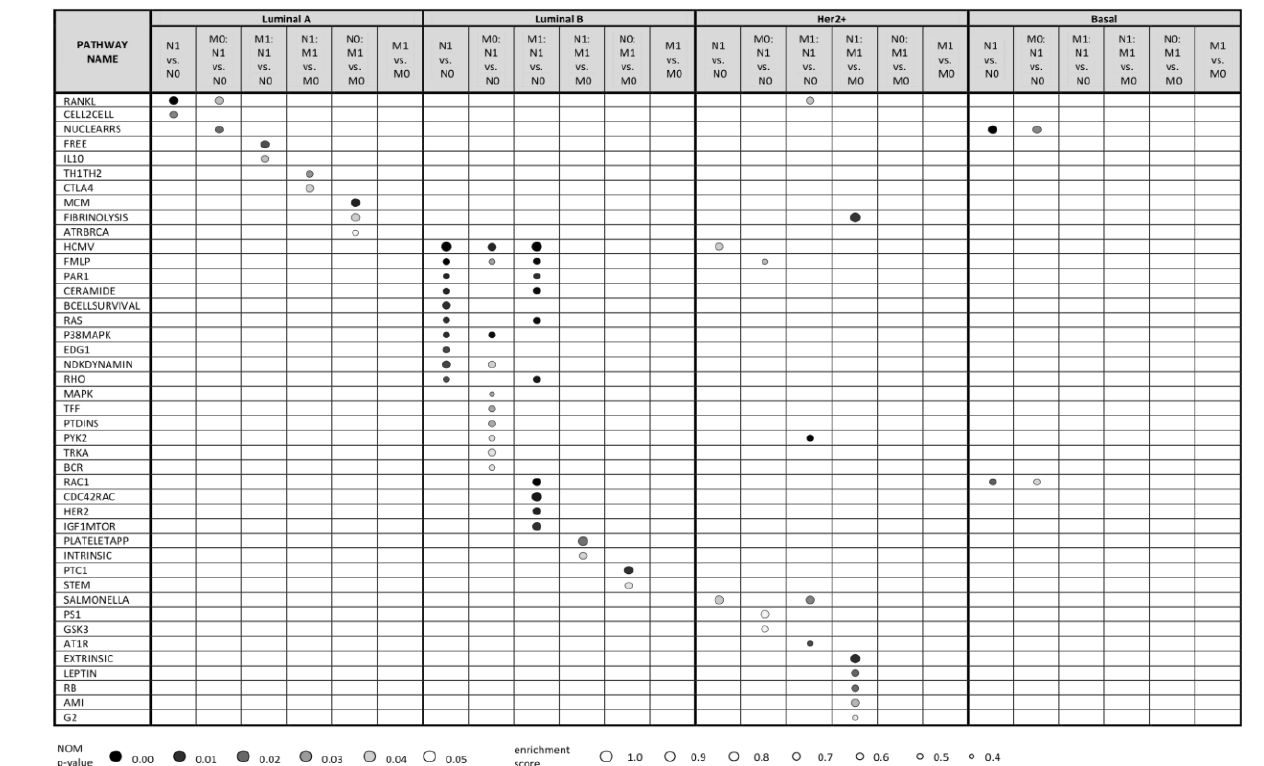
Figure 1. Top 10 statistically significant pathways (NOM p -value < 0.05) resulting from Gene Set Enrichment Analysis (GSEA) based on transcriptomic profiles of breast cancer patients from SUPERTAM_HGU133A dataset. Using SCMOD2 classifier, patients were classified into 4 breast cancer molecular subtypes, resulting in 341 luminal A, 281 luminal B, 71 Her2 + and 143 basal patients. To demonstrate di ff erences in molecular mechanisms included in lymph node metastasis (N1) and distant metastasis (M1), expression profiles were compared under 6 conditions (N1 vs. N0, M0: N1 vs. N0, M1: N1 vs. N0, N1: M1 vs. M0, N0: M1 vs. M0, M1 vs. M0) related to these two events. Pathways were searched against Biocarta pathway database. Up to 10 statistically significant pathways are shown for each condition within each subtype. No statistically significant pathways were identified under M1 vs. M0 condition for patients with all breast cancer subtypes. M0: N1 vs. N0, lymph node positive vs. negative tumors; all distant metastasis negative; M1: N1 vs. N0; lymph node positive vs. negative tumors; all distant metastasis positive; M1 vs. M0, distant metastasis positive vs. negative tumors; N0: M1 vs. M0, distant metastasis positive vs. negative tumors; all lymph node negative; N1: M1 vs. M0; distant metastasis positive vs. negative tumors; all lymph node positive; N1 vs. N0, lymph node positive vs. negative